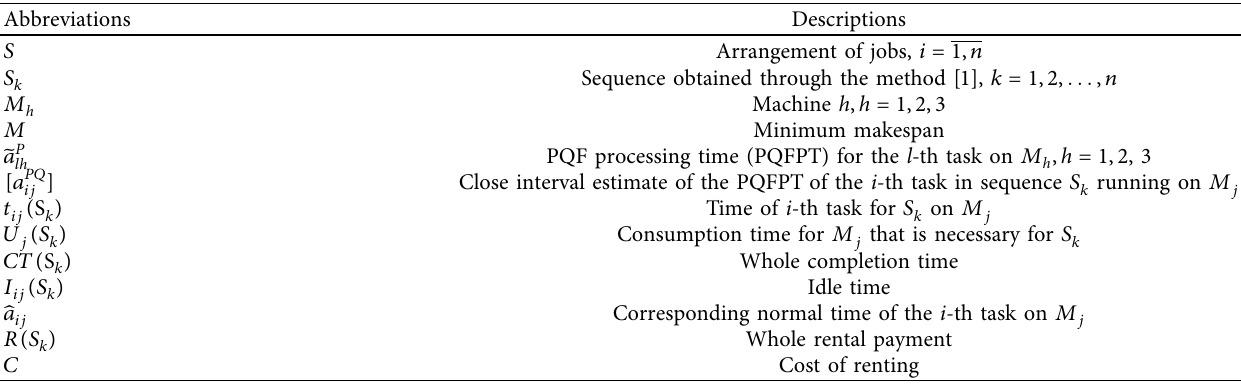
Table 1: List of symbols.